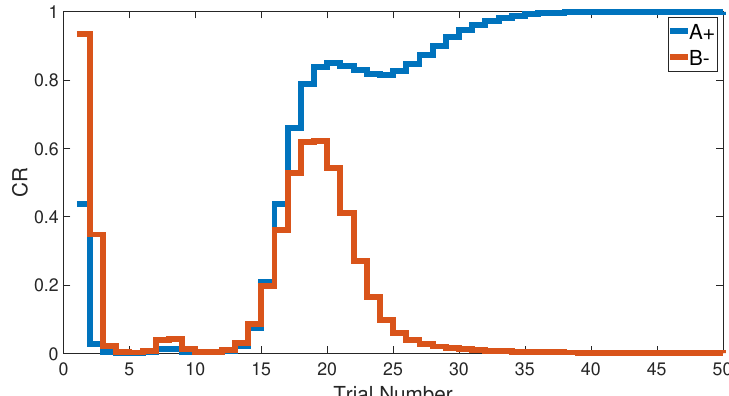
Figure 9. Stimulus discrimination task of the CHCQ-disrupted system.